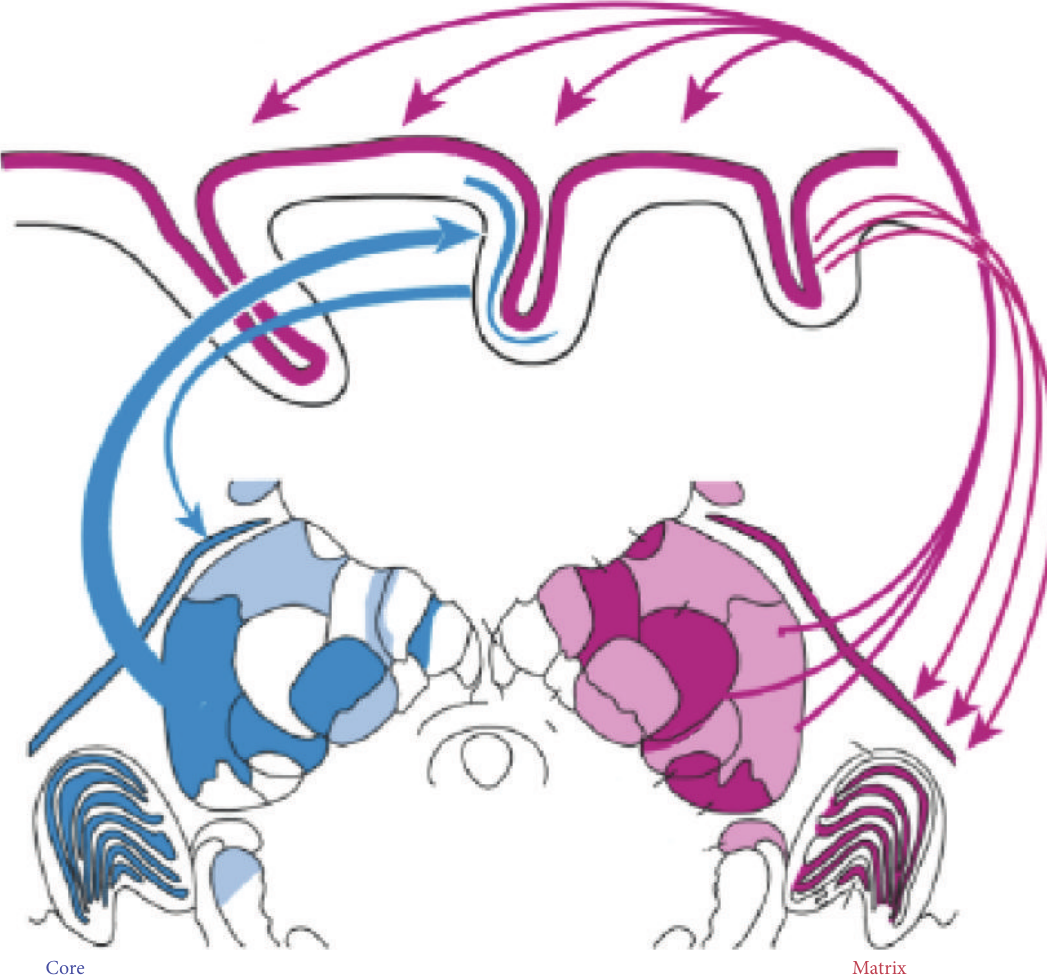
Figure 4: A thalamocortical system to reconcile differences between EEG and MEG sleep spindles. The distribution of matrix cells (red) and core cells (blue) indicated in a frontal section through the middle of a macaque monkey thalamus. The core thalamic projections are topographically ordered to the middle layers of a single cortical field. The matrix thalamic projections collectively project diffusely to the superficial layers of widespread cortical fields. Modified from [24].